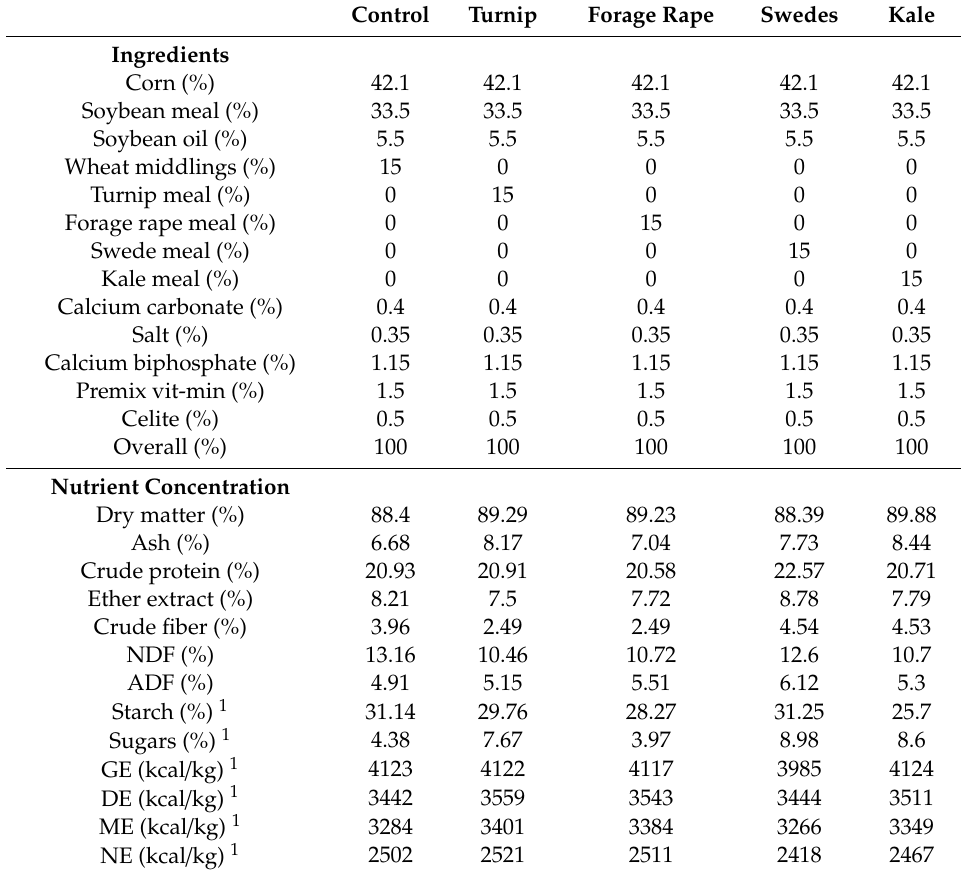
Table 1. Ingredients and chemical composition of experimental diets tested in growing pigs. Brassica crop meal was included at 15% of the diet by replacing wheat middlings that was included in the control diet. Control Turnip Forage Rape Swedes